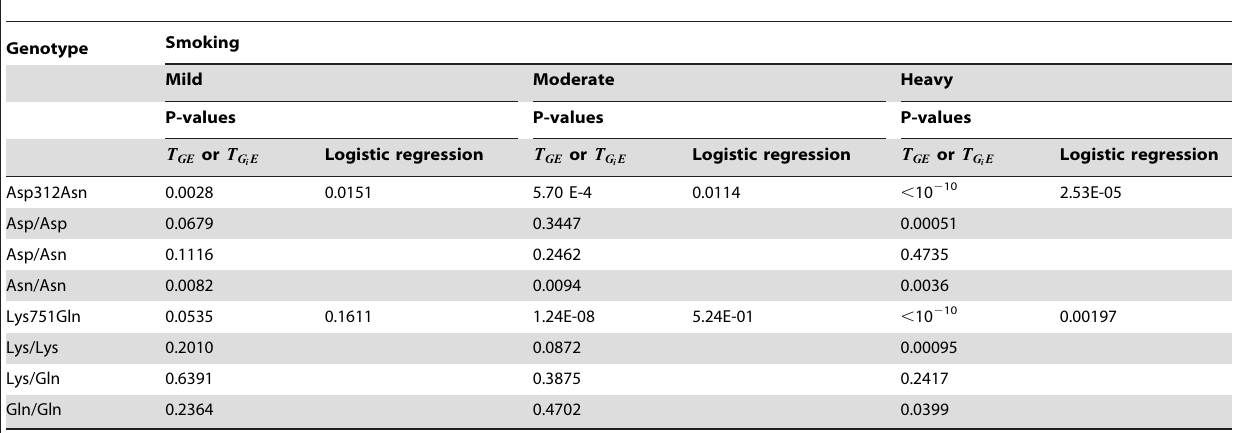
Table 4. Comparison of p-values for the mutual information-based statistics and logistic regression to the interaction between ERCC2 polymorphisms and smoking in lung